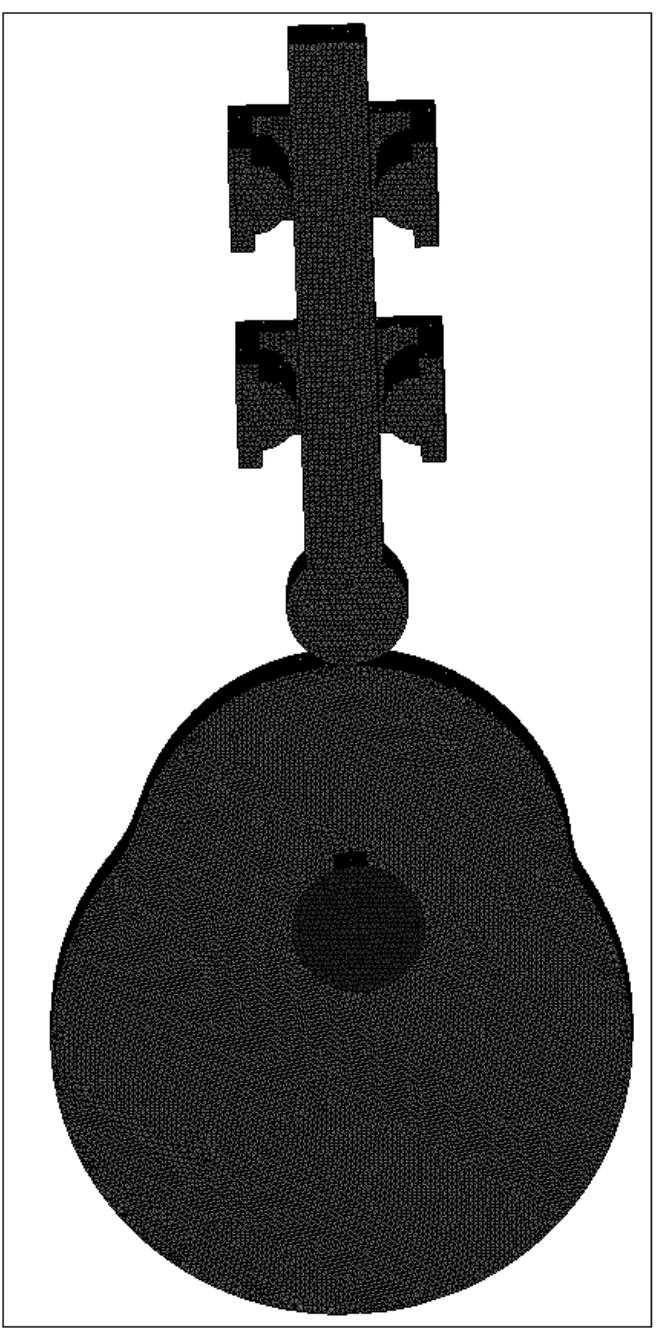
Figure 7. Mesh generation of cam-follower mechanism for profile no.(3).